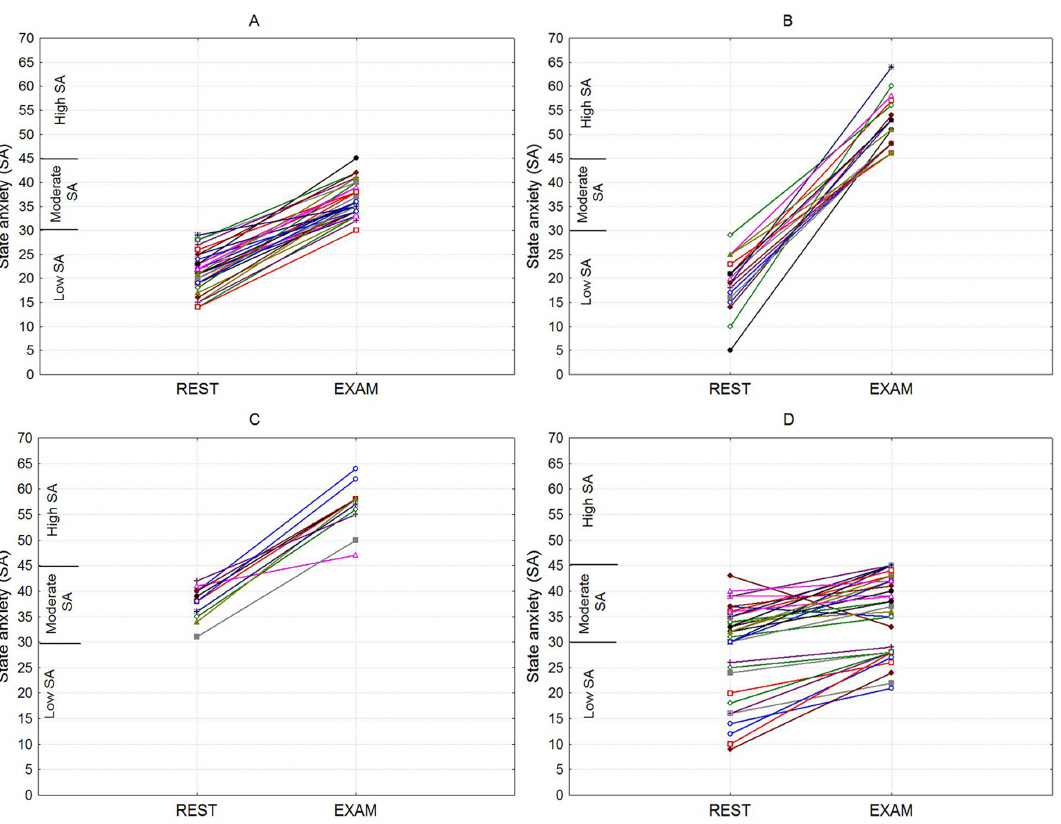
Fig 1. Individual data for examination-induced changes in state anxiety from rest session to the exam session. (A) Increasing from low to moderate anxiety levels. (B) Increasing from low to high anxiety levels. (C) Increasing from moderate to high anxiety levels. (D) Absence of qualitative changes in